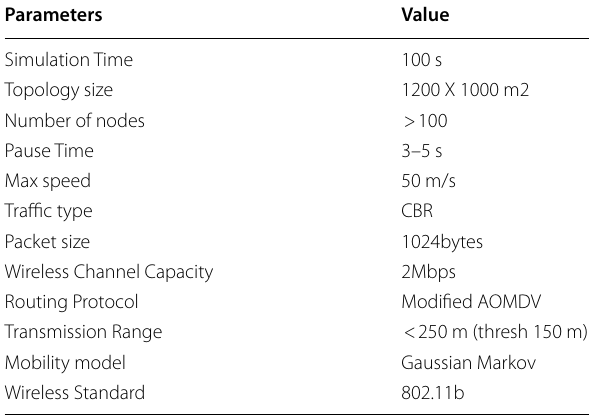
Table 4 The simulation parameters